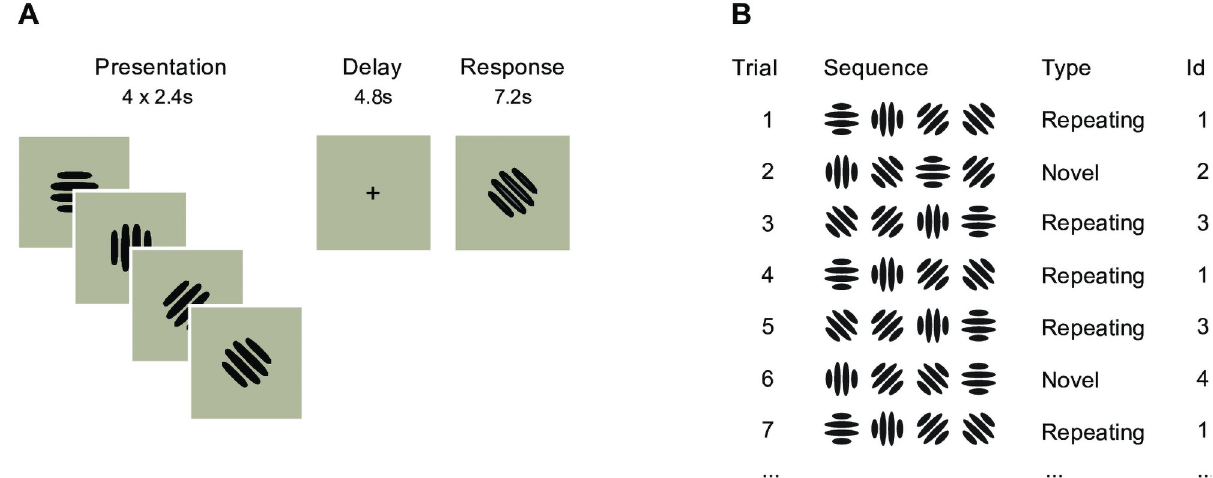
Fig 2. Task. (A) Single trial: participants had to recall a sequence of four Gabor patches in the order they were presented after a 4.8s delay period using a button-box. The size of the stimuli within the display area is exaggerated for illustrative purposes. (B) Trial types and progression: 2/3 of the trials were repetitions of the same two individual sequences ( repeating sequences), while 1/3 of the trials were novel unseen orderings of the items ( novel sequences). The identity and order of repeating and novel sequences were pseudo-randomised across participants.